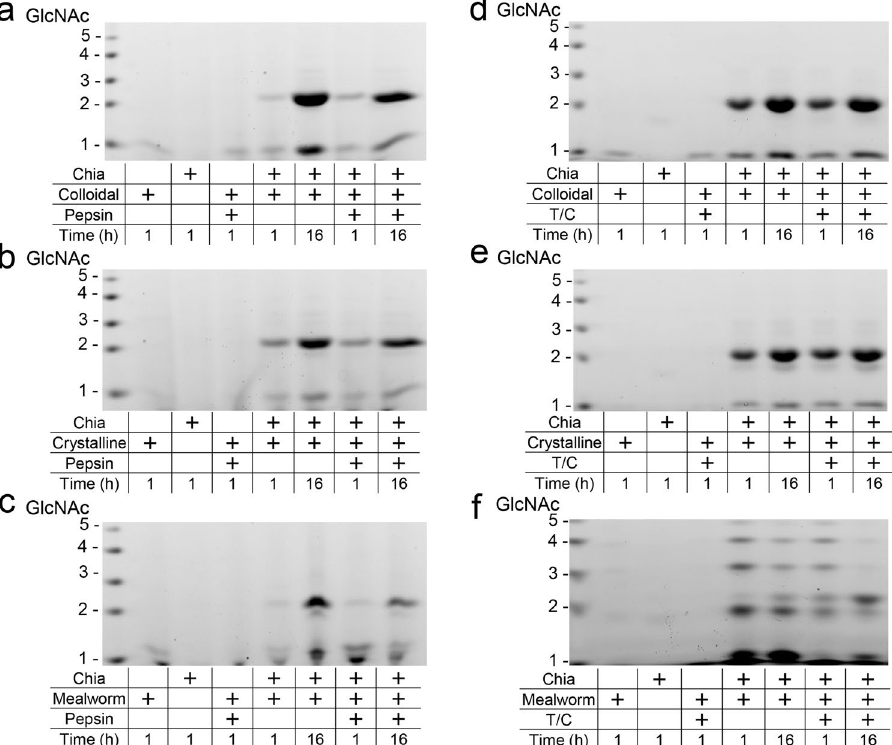
Figure 4. Chicken Chia degrades chitin substrates into (GlcNAc) 2 in gastrointestinal condition. ( a , d ) Colloidal and ( b , e ) crystalline chitin substrates were degraded by purified Chia at ( a , b ) pH 2.0 or ( d , e ) pH 7.6 for 1 or 16 hours in the presence of pepsin or trypsin and chymotrypsin at 1:1 ratio. Shells of mealworm were also incubated with the enzyme for 1 or 16 hours under ( c ) stomach or ( f ) intestine condition. Resulting mono- and oligosaccharides were covalently labeled at their reducing end-groups with a fluorophore, followed by fluorophore-assisted carbohydrate electrophoresis (FACE). N -acetyl-chitooligosaccharides are shown in the left margin as